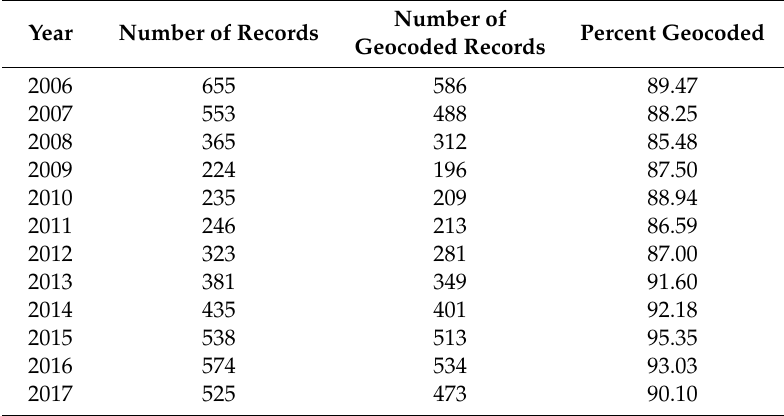
Table 2. Residential building permits (2006–2017): geocoding